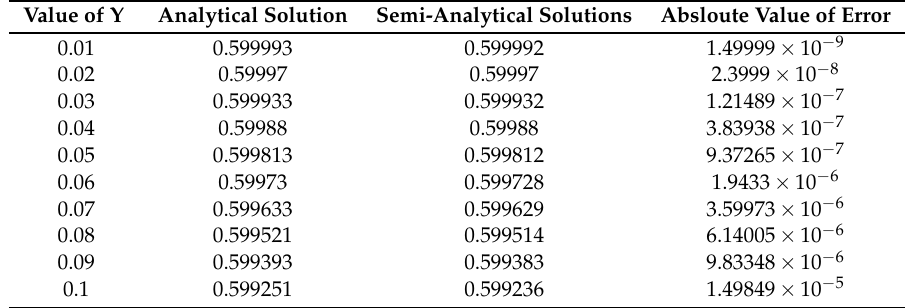
Table 1. Values of computational and semi-analytical solutions for different values of Υ to show the accuracy of the obtained